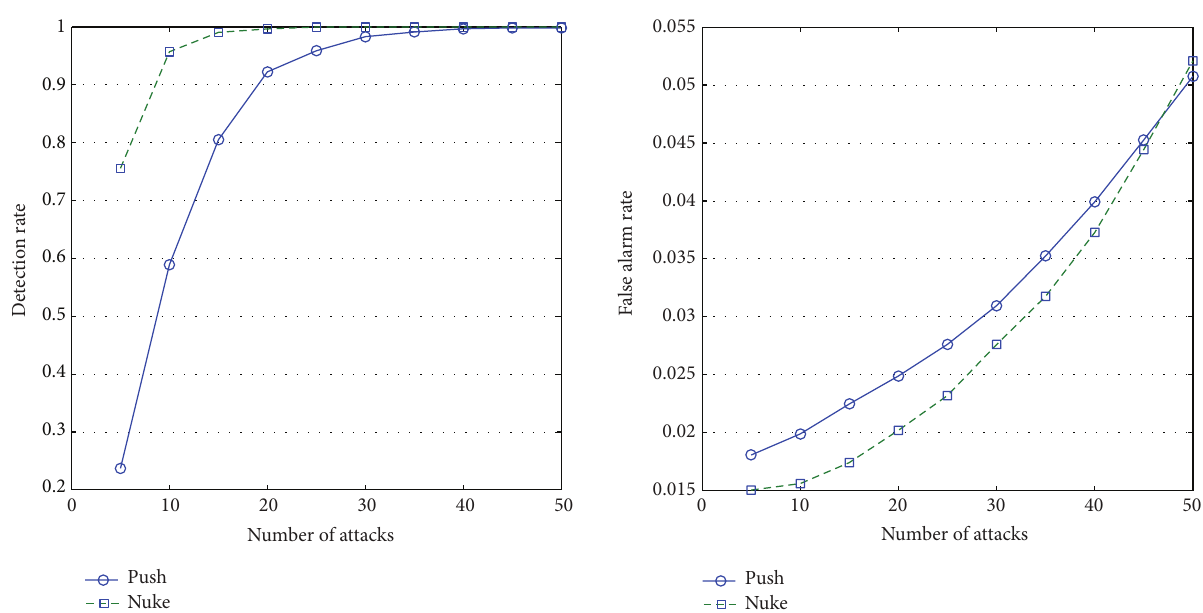
Figure 7: Detection rates and false alarm rates of scallop